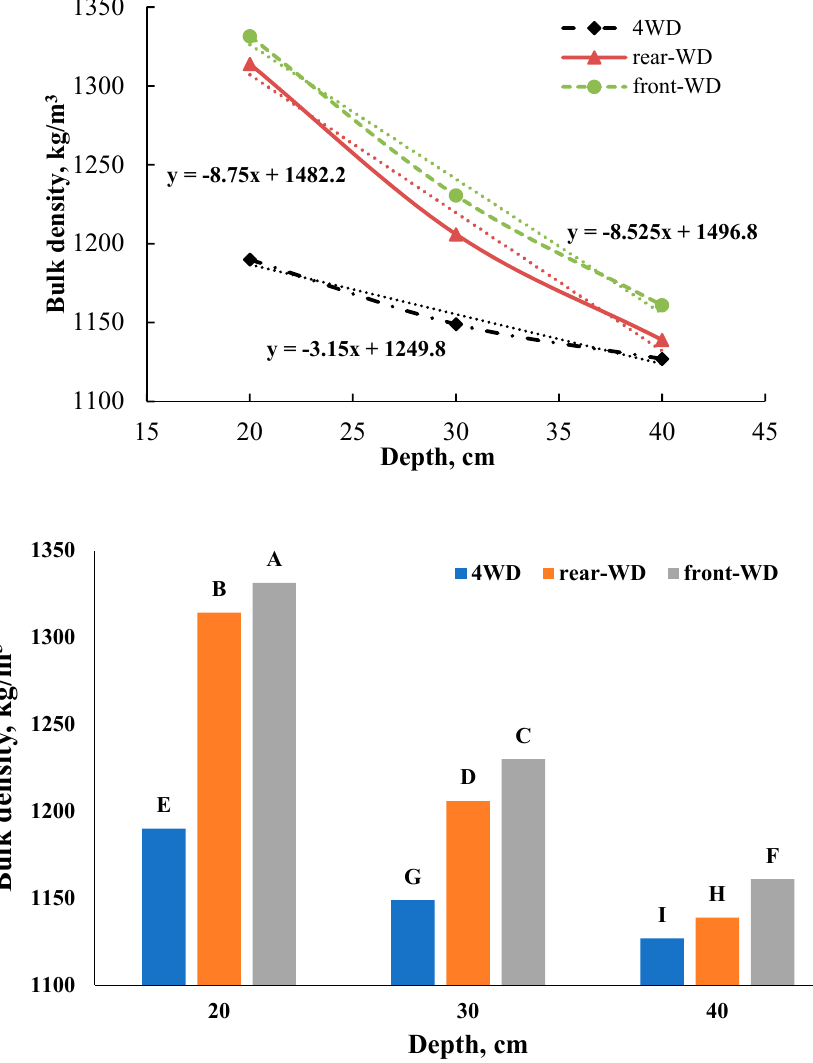
Figure 4. Effects of the drive system on soil compaction at three depths and depths here are depths from the untrafficked soil surface to the centers of the soil cores (different letters shows significant difference between treatments).